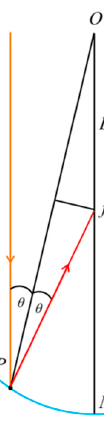
Figure 2. Scheme of the reflection in a cylindrical mirror.